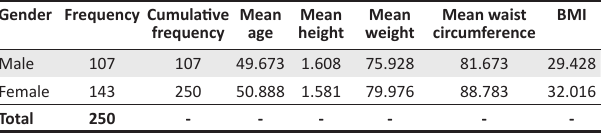
TABLE 2: Age, height, weight, waist circumference and body mass index distribution based on gender. Gender Frequency Cumulative Mean frequency